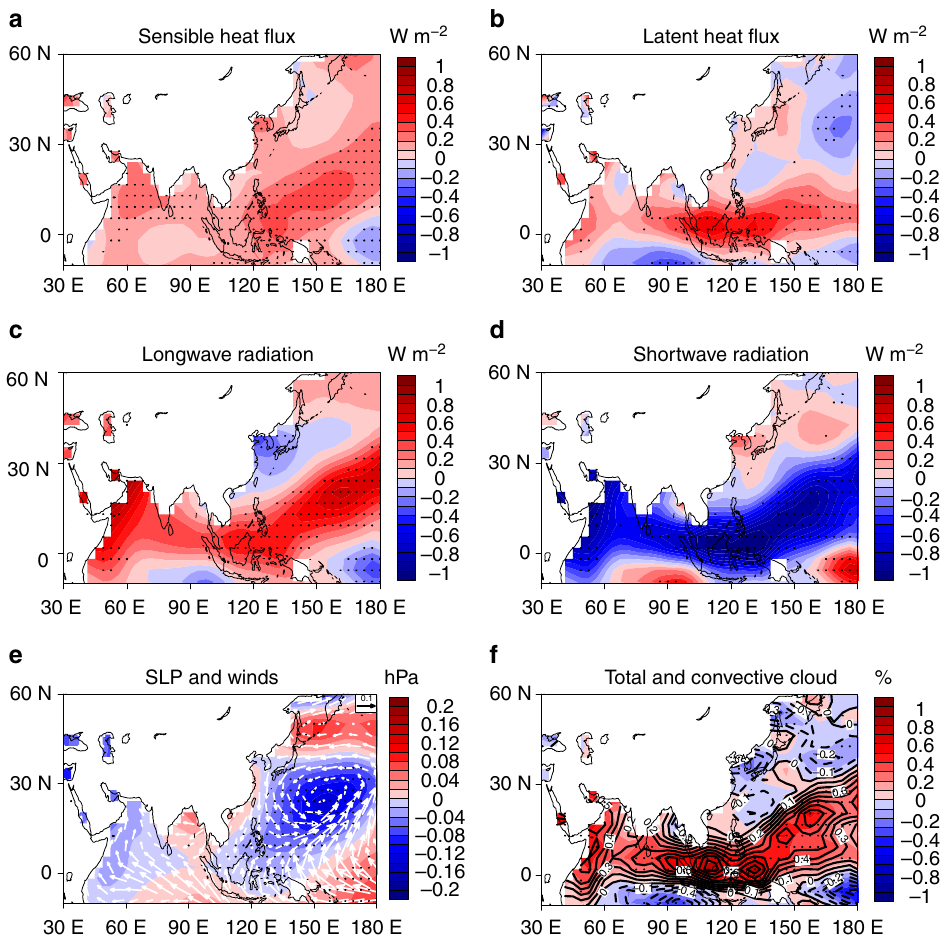
Figure 4 | Physical processes involved in the western tropical Pacific SSTdecadal variability in the ATL_VARMIX simulations. The regression maps of ( a ) surface sensible heat flux, ( b ) surface latent heat flux, ( c ) net surface longwave radiation and ( d ) net surface shortwave radiation (units: Wm (cid:2) 2 ) with respect to the normalized western tropical Pacific SST index at decadal time scales. All fluxes are defined to be positive downward. ( e ) Regressions of the sea level pressure (shading, units: hPa) and surface wind filed (vector, units: ms (cid:2) 1 ) with respect to the normalized western tropical Pacific SST index at decadal time scales. ( f ) Regressions of the total cloud amount (shading, units: %) and convective high-level cloud amount (contour, units: %) with respect to the normalized western tropical Pacific SST index at decadal time scales. Dotted shading in a – f stands for the regression coefficients significant at the 95% confidence level. The long-term linear trends for 1900–2013 in all variables were removed before the regression